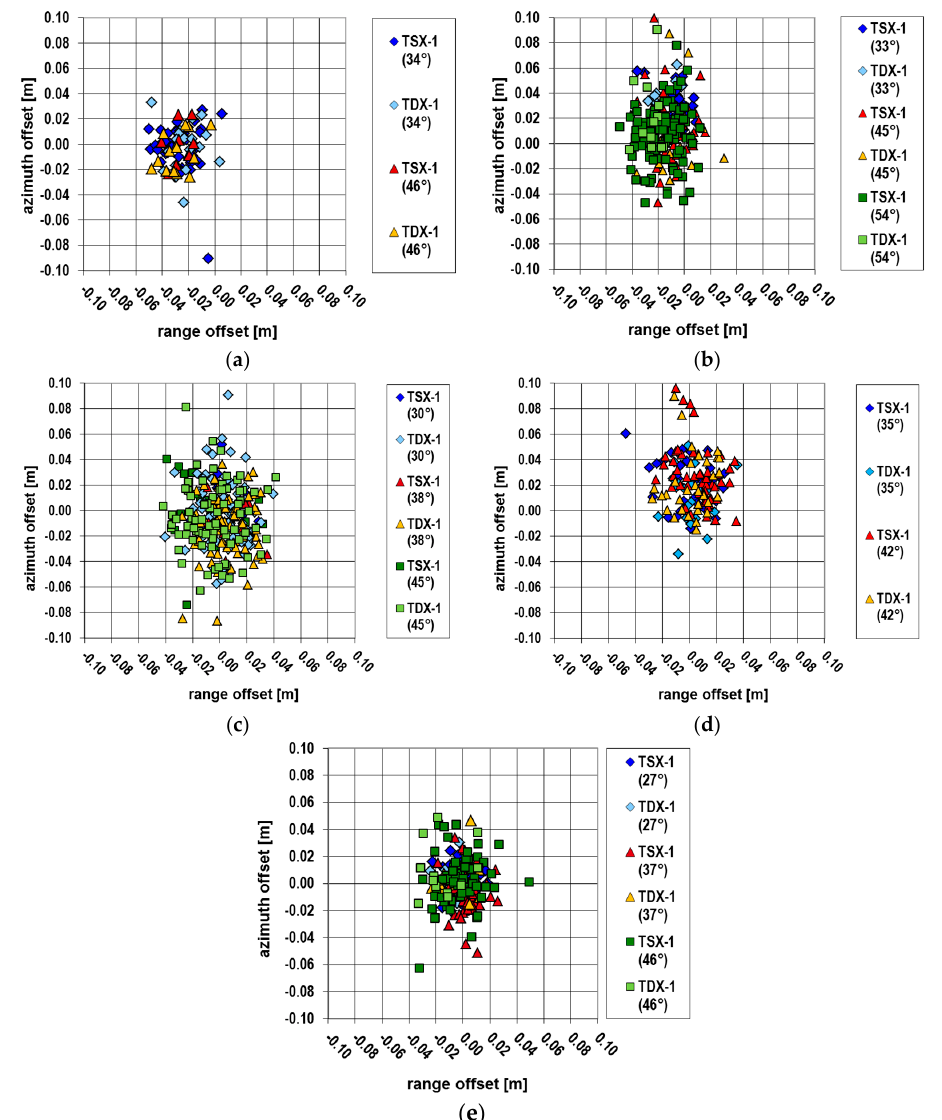
Figure 7. Scatter plots of the obtained azimuth and range offsets: ( a ) Wettzell Ascending; ( b ) Wettzell Descending; ( c ) GARS O’Higgins Ascending; ( d ) GARS O’Higgins Descending; ( e ) Metsähovi Descending.